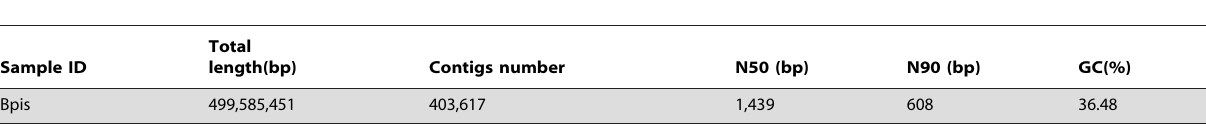
Table 4. Re-assembly of adzuki bean weevil genome after decontamination.